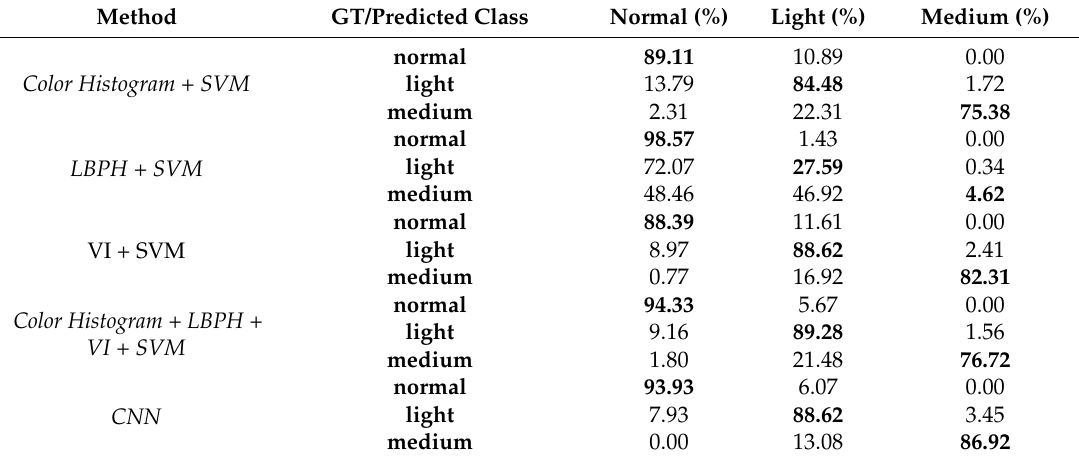
Table 6. Confusion matrix of different